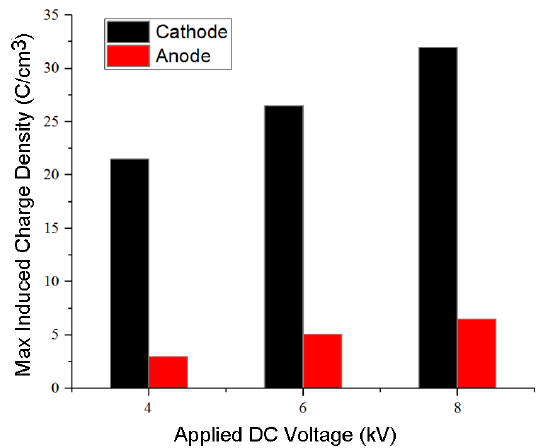
Figure 3. Max induced charge density on the electrodes after instantaneous power off under different DC voltages at 20 °C (volt ‐ off).